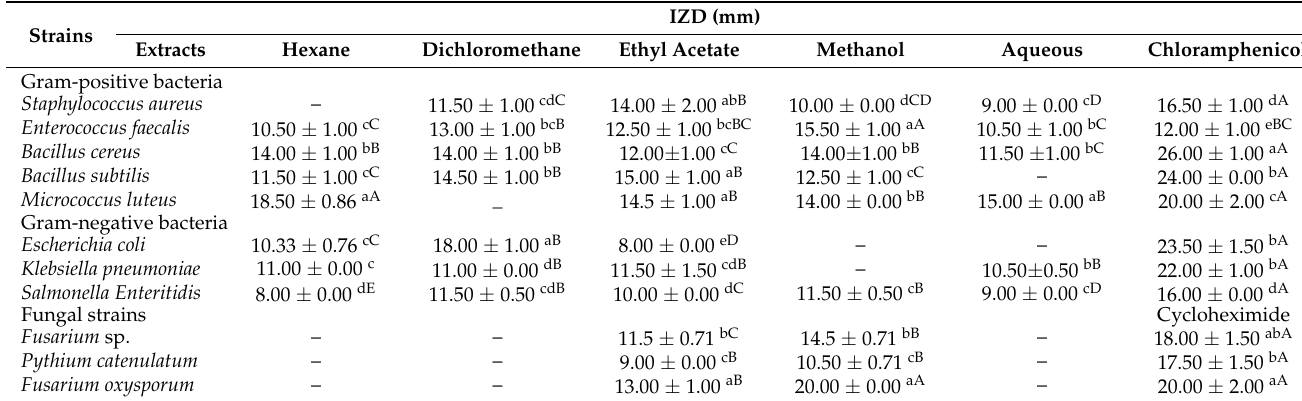
Table 1. Antibacterial and antifungal activities of E. humile